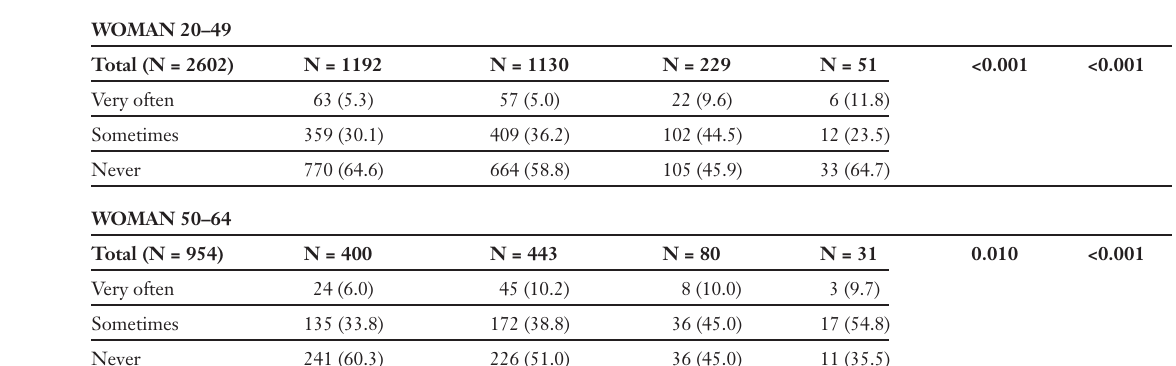
Women: crude prevalence rates of decrease in sexual desire for levels of job